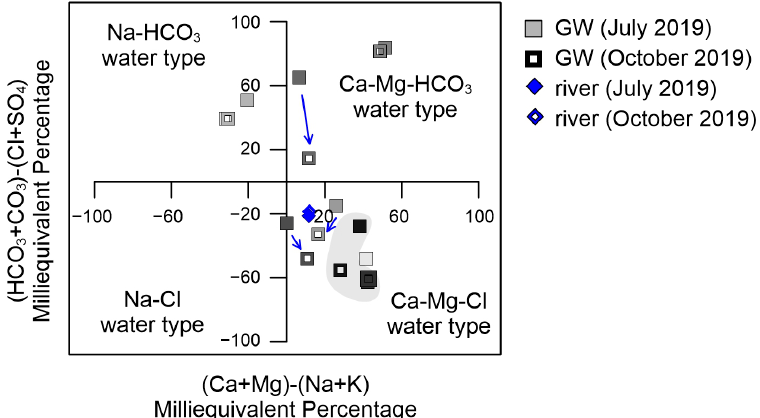
Figure 9. Hydrochemical variations due to weir operation in July (after opening the weir) and October 2019 (after weir closure) by Chadha’s classification diagram explaining the groundwater (square) and river water (diamond) types.